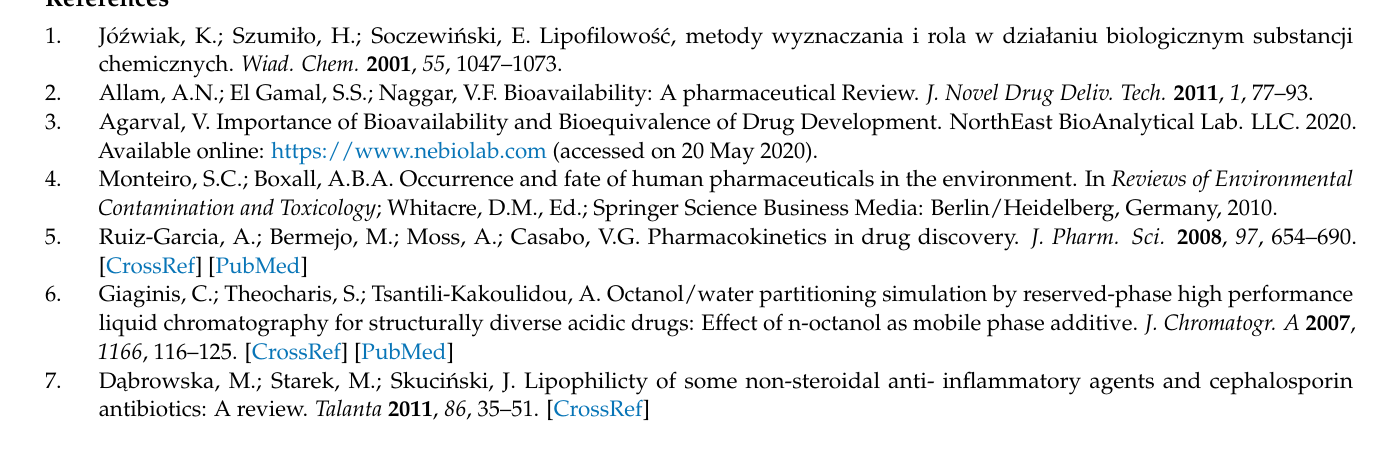
Table S8. Terms of the linear correlation according to equations logP calc(1) = b + a logP calc(2)